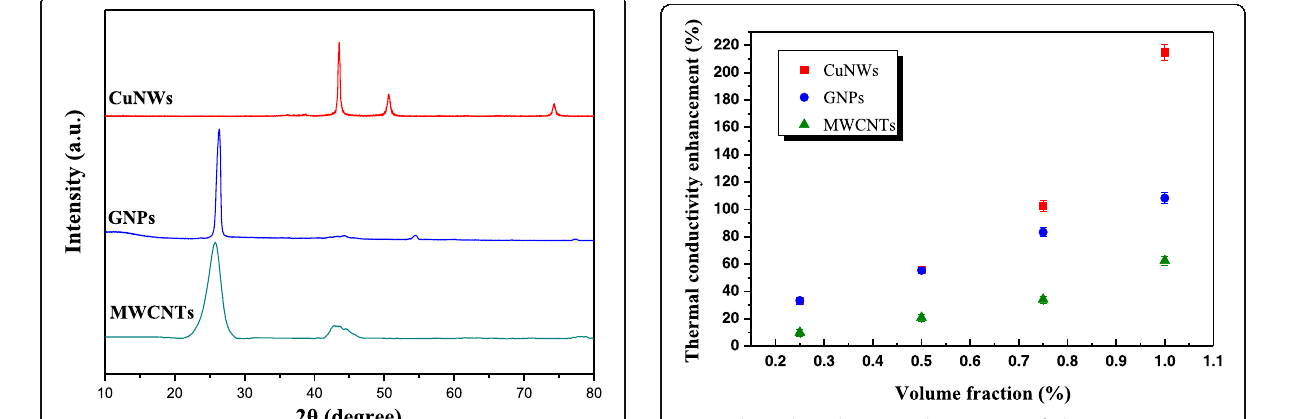
Fig. 3 Thermal conductivity enhancements of silicone composites with different fillers as a function of volume